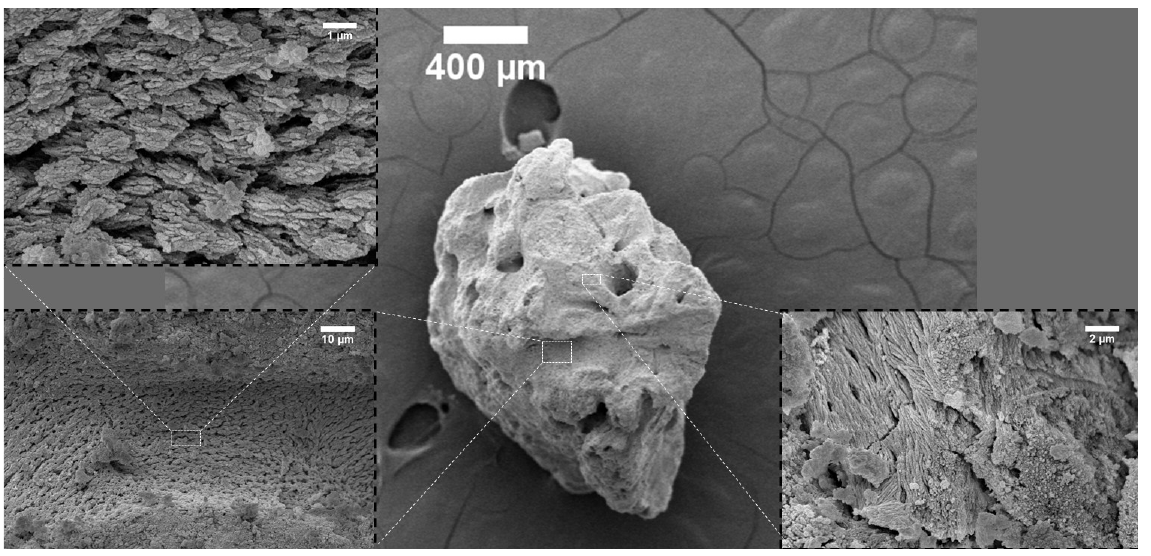
Figure 5. SEM images of Geistlich Bio-Oss.